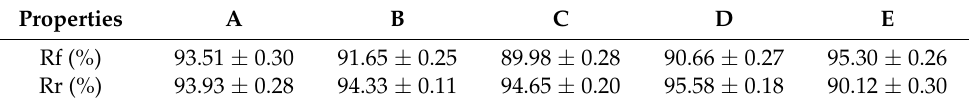
Figure 7. DSC curves of ER composites with different DCP content: ( a ) crystalline peaks of DSC curves; ( b ) melting peaks of DSC curves; ( c ) crystalline degree obtained from DSC curves; and ( d ) Tm obtained from DSC curves. Table 2. Effect of the DCP dosage on the R f and R r values for SME in the composites.